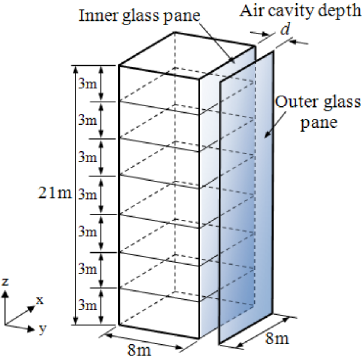
Fig. 1. Schematic diagram of physical model for DSF 1